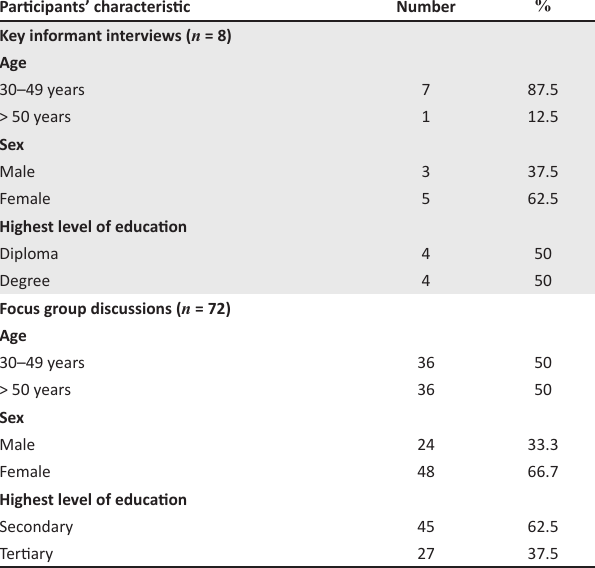
TABLE 1: Interview and focus group discussion participants’ characteristics. Participants’ characteristic